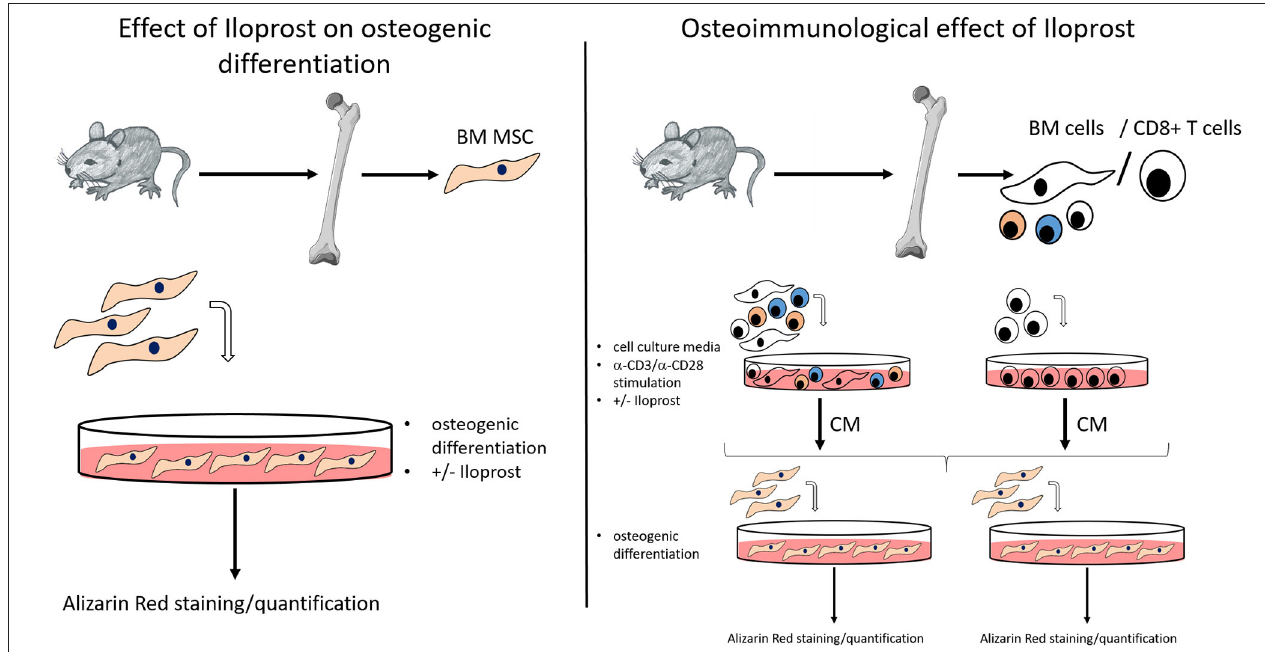
FIGURE 1 | Methodological scheme for the in vitro analysis of the osteogenic effect and osteoimmunological effect of Iloprost. BM MSC, bone marrow mesenchymal stromal cells; BM cells ,bone marrow cells; CM, conditioned media.